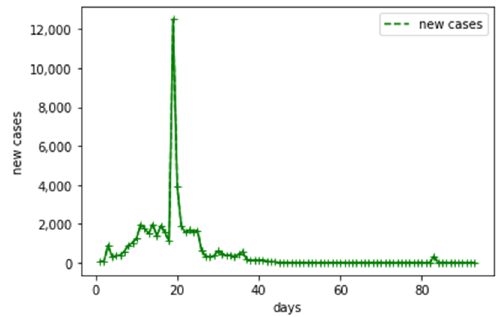
Figure 2. Time series of the volume of microblogs.